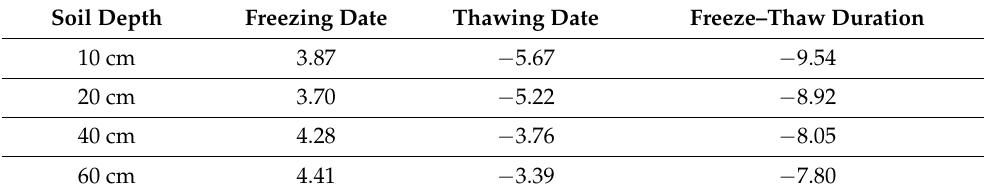
Figure 12. Climate zones on the Tibetan Plateau.